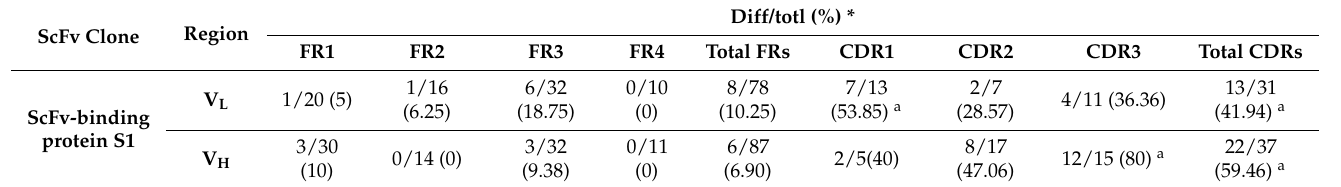
Figure 6. Expression and grouping analysis of scFv antibody. ( A ) Thirteen randomly selected scFv clones were loaded onto respective wells of SDS-PAGE. ( B ) The PVDF membrane was probed by mouse anti-HA tag antibodies at 1:5000 dilutions, then detected by HRP-conjugated rabbit anti-mouse IgG antibodies at 1:5000 dilutions. The expected scFv molecular mass was about 26 kDa. ( C ) All the scFv antibodies had the same amino acid sequences and were classified as one group. Table 2. Amino acid mutation rates of the light- and heavy-chain genes of the scFv antibody. ScFv Clone